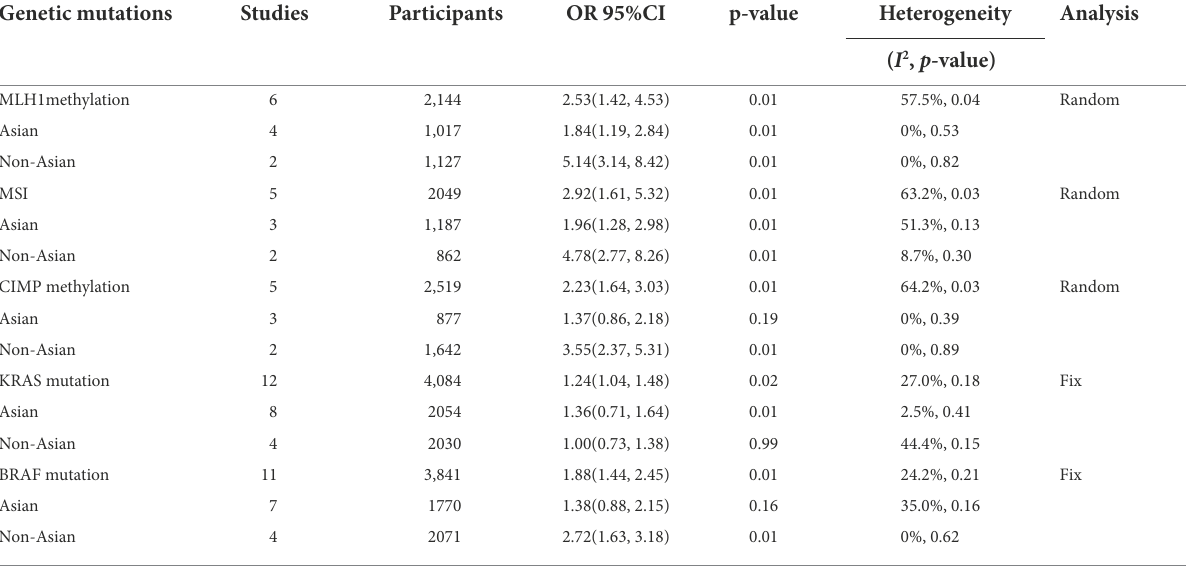
TABLE 3 The correlation between Fusobacterium nucleatum and molecular characteristics of cancer. Genetic mutations